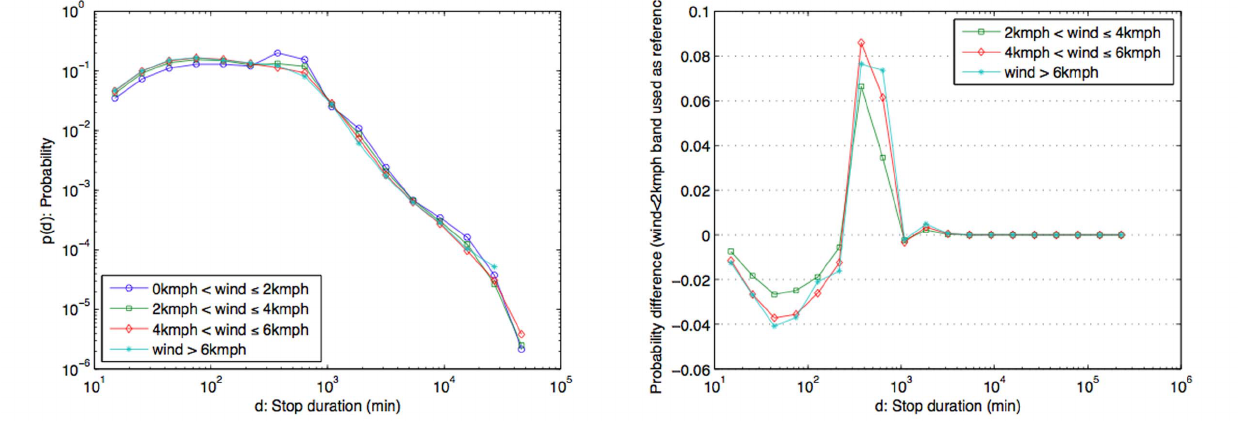
Figure 11. Probability mass function of stop duration under different bands of wind speed and probability difference compared with the wind speed band of less than 2 kmph.